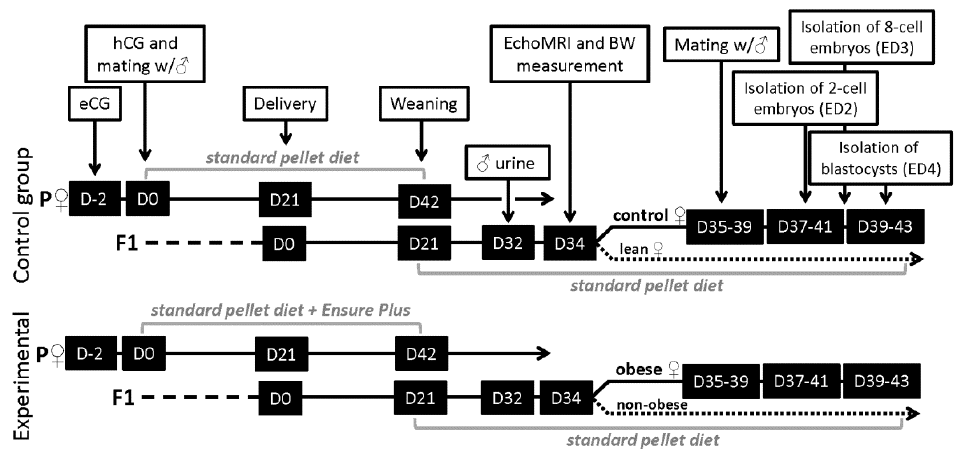
Figure 1. Mouse intergenerational model of diet-induced obesity: Schematic overview of breeding protocol. P, parental generation; F1, filial generation; eCG, pregnant mare’s serum gonadotropin (5 IU ip); hCG, human chorionic gonadotropin (4 IU ip); EchoMRI, non-invasive nuclear magnetic resonance instrument; BW, body weight; ED2, ED3, ED4, embryonic day 2, 3, and 4. Standard pellet diet: 225 g/kg of crude protein, 27 g/kg of crude fat, 30 g/kg of crude fiber, 61 g/kg of ash, and 58 g/kg of saccharides (M1, 3.2 kcal/g). Ensure Plus: high-energy nutritional product (Abbot Laboratories, 1.5 kcal/mL).